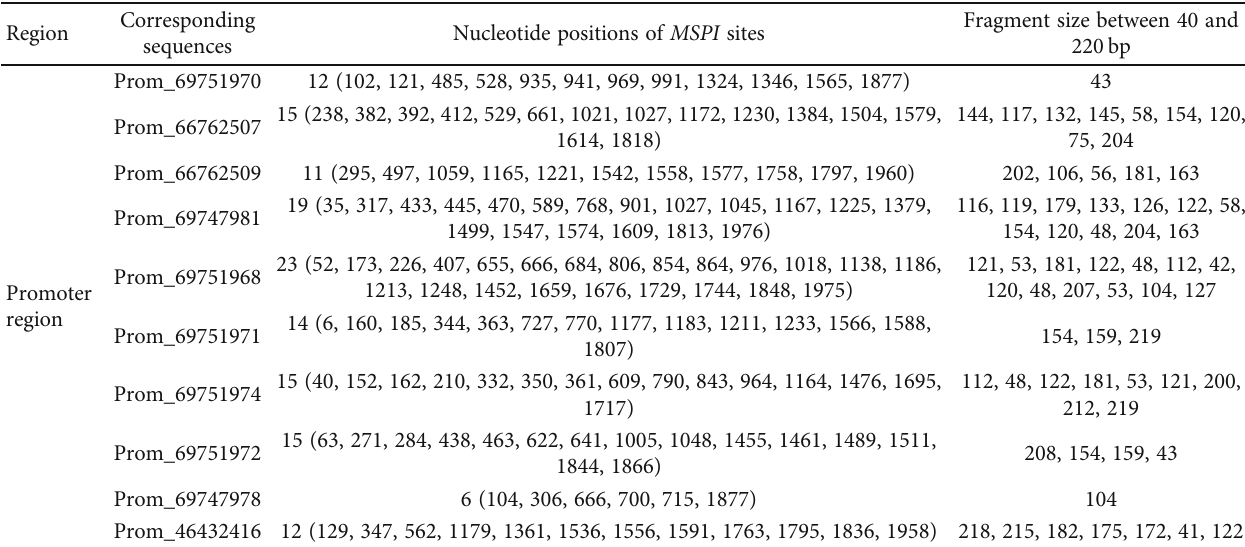
Table 7: MspI cutting sites and fragment sizes in promoter regions.